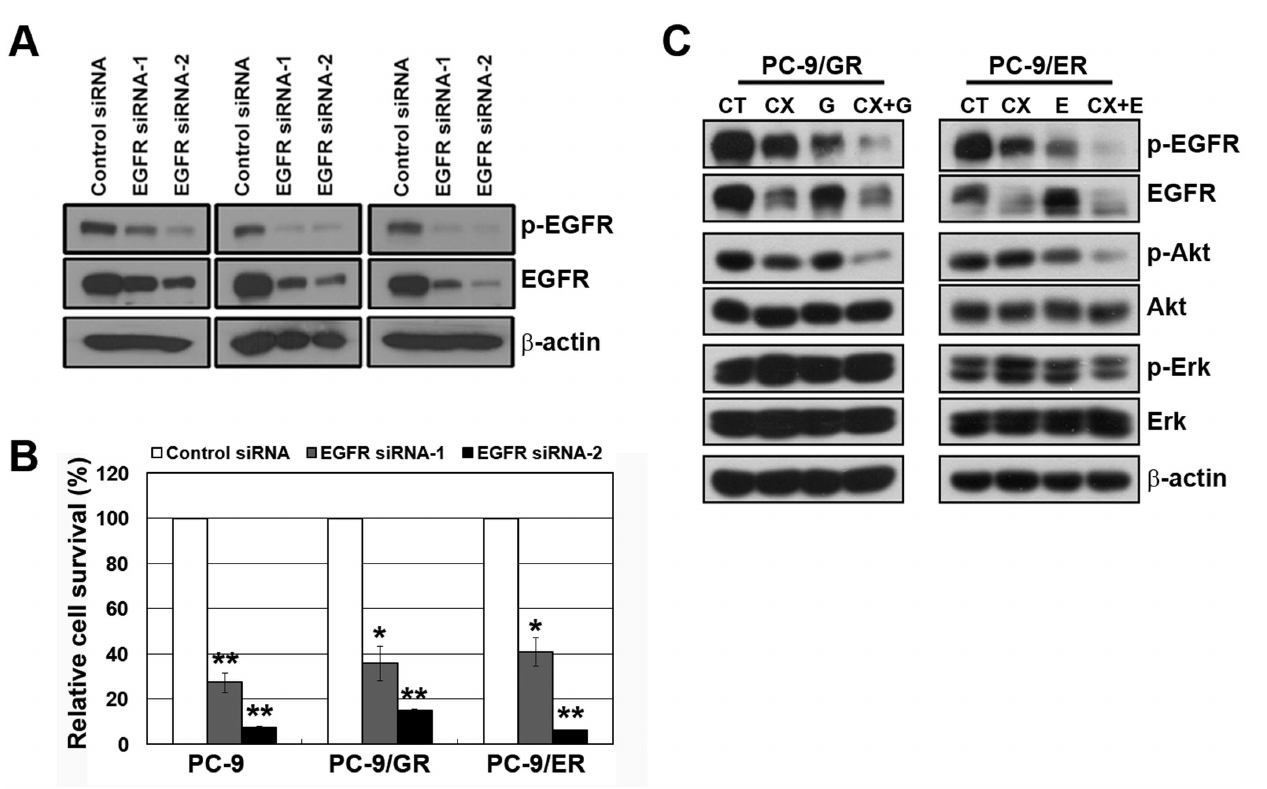
Figure 4. Addition of CX-4945 to EGFR-TKIs substantially suppressed the EGFR signaling pathway in gefitinib/erlotinib-resistant, PC-9 cells. A and B, Control and EGFR siRNAs (100 nM) were introduced into parental or resistant cells, and EGFR suppression was confirmed by Western blot